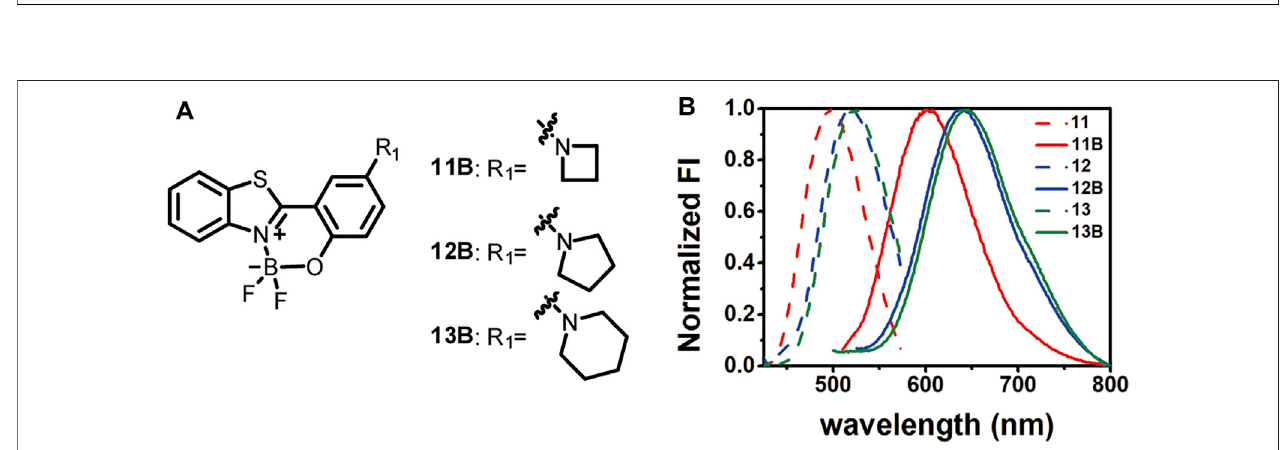
FIGURE 3 | Structures of 11B-13B (A) and their emission spectra in comparison to those before BF 2 -complexation in acetonitrile (B) .